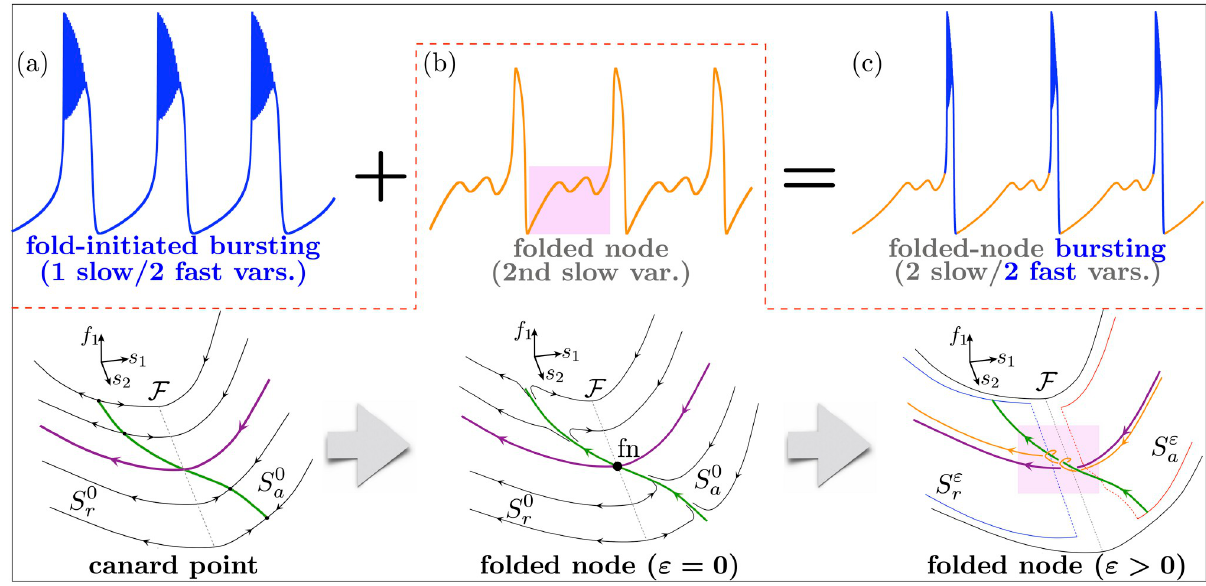
Fig 6. Folded-node bursting in a nutshell. The top row shows the essentials of folded-node bursting: (a) A fold-initiated bursting system ( f 1 , f 2 , s 1 ) ( f 1,2 are fast and s 1 is slow) with (b) an added slow variable s 2 creating a folded node and corresponding to the main parameter of the 3D burster organizing spike-adding transitions gives (c) a 2 slow variables/2 fast variables folded-node burster. The bottom row is an extension of the top panel (b) and shows the essentials of folded-node dynamics (whose typical time course is shown in the top panel (b)): A canard point ( ε = 0) in the ( f 1 , f 2 , s 1 ) bursting system with s 2 as parameter (left panel) becomes a folded node (black dot, center panel, ε = 0) when the slow dynamics put on s 2 is evolving, for ε = 0 along the attracting and repelling parts S 0 of the critical manifold; for small ε > 0, this folded node creates small-amplitude oscillations nearby, organized by a ; r attracting and repelling slow manifold S ε (perturbations of S 0 ) and responsible for the quiescent oscillations of the folded-node burster in the resulting a ; r a ; r 4D system. See S1 Text for a glossary of labels and technical terms.